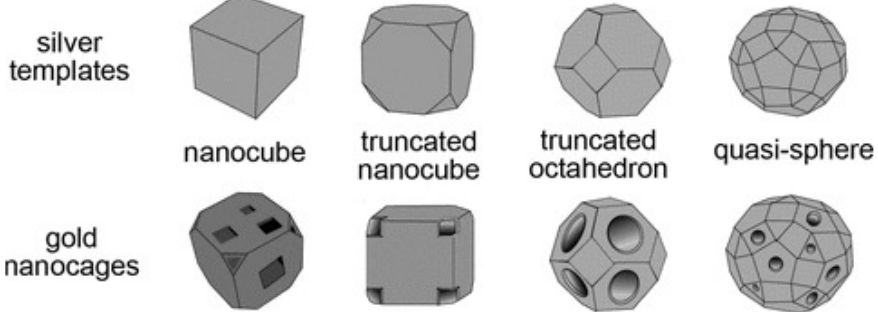
Figure 3. Schematic illustrations summarizing four major types of Au nanocages derived from the corresponding templates of Ag: A single-crystal cube with sharp corners; a single-crystal cube with truncated corners; a single-crystal octahedron with truncated corners; a polycrystalline, quasi- spherical particle. Reprinted with permission from [51]. Copyright 2010, Wiley.